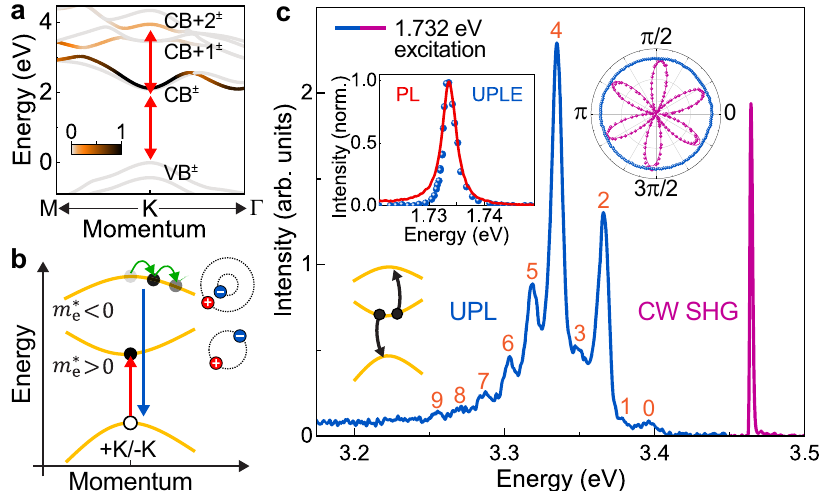
Fig. 1 Formation of high-lying excitons (HX) in monolayer WSe 2 , with an electron in an upper conduction band and a hole in the top-most valence band. a Calculated GW band structure of bare monolayer WSe 2 . Higher (lower) energy spin-split bands are labeled by + ( – ) superscripts. The color indicates normalized oscillator strength of electrons making a transition from the top valence band (VB + ) to the different conduction bands (CB, CB + 1, and CB + 2). Red double-headed arrows mark the exciton resonances invoked to explain quantum interference in optical second-harmonic generation (SHG) 7 . b Resonant pumping of band-edge A excitons (red arrow) results in momentum-selective excitation of higher-lying bands at the K -symmetry points. Electrons from the high-lying band recombine with holes from the valence band to emit UV light (blue arrow), measured as upconverted photoluminescence (UPL) spectra. Electrons in the fi rst conduction band (CB) relax towards the K -points by emitting phonons, whereas electrons in the downwards-curved higher-lying conduction band relax away from the K -points (green curves). c PL spectrum of hBN-encapsulated monolayer WSe 2 at 5 K under narrow-band continuous-wave (CW) excitation at 1.732 eV. The peak at 3.464 eV arises from SHG (purple), below which upconverted PL (UPL) from the HX (blue) is observed in the form of a set of 10 peaks. The bottom-left inset indicates the Auger-like process responsible for populating exciton states from the higher-lying conduction band, generating UPL. The intensity of the SHG (purple dots) co-polarized with the laser varies as the laser polarization is rotated with respect to the crystal lattice (right inset), whereas the HX luminescence (blue dots) does not. The top-left inset shows the UPL excitation (UPLE) spectrum of the HX (blue), which matches the band-edge A-exciton PL spectrum